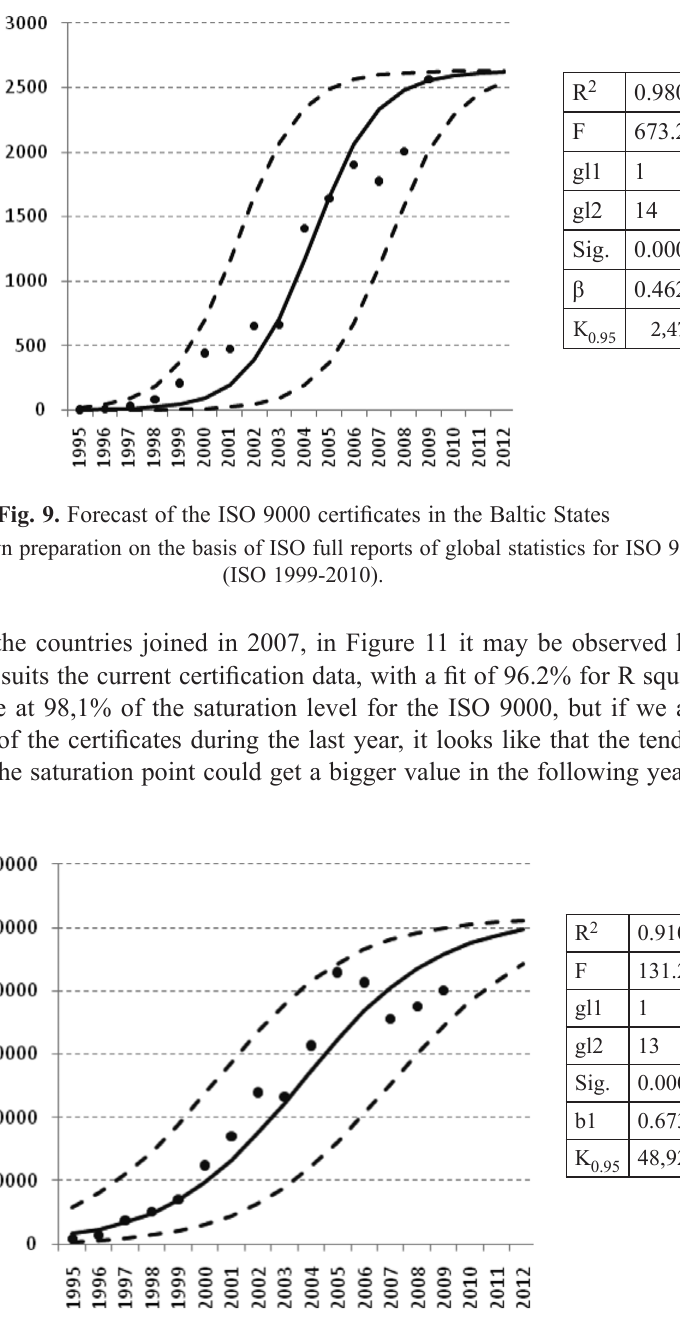
Fig. 10. Forecast of the ISO 9000 certificates in rest of the countries joined in 2004 Source: Own preparation on the basis of ISO full reports of global statistics for ISO 9000 (ISO